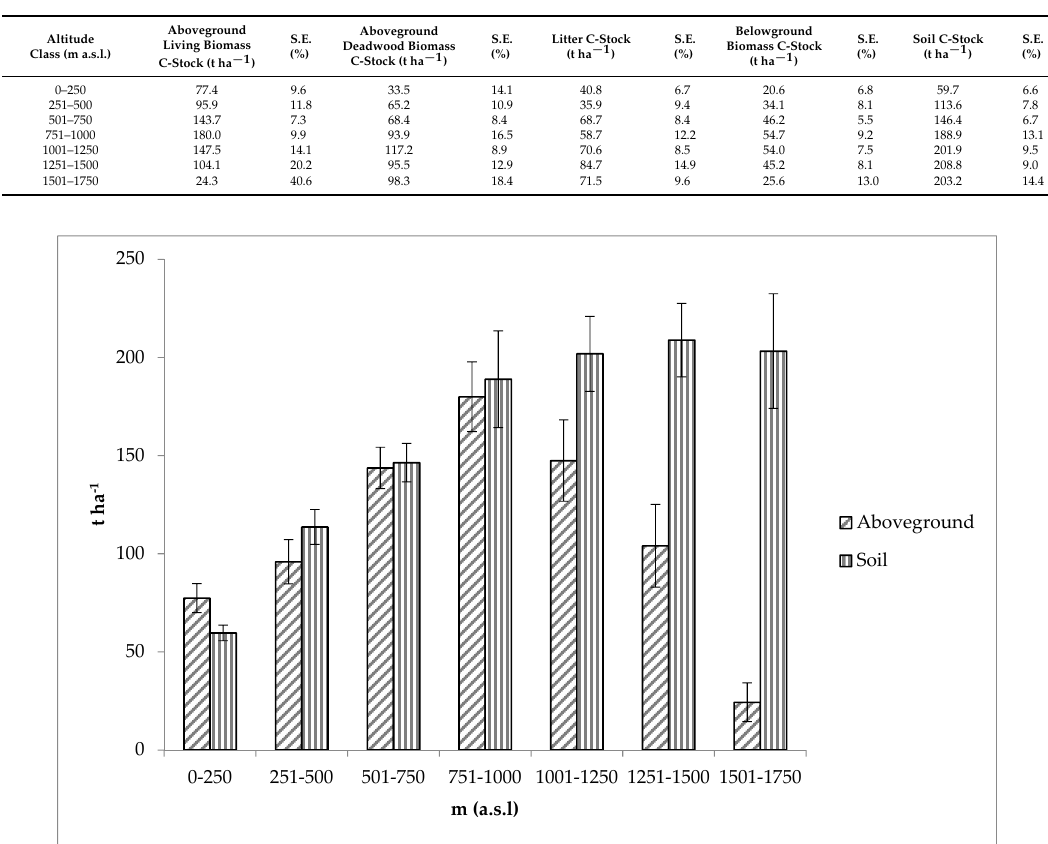
Figure 3. C-stock per hectare for aboveground living biomass (Aboveground) and soil (Soil) by altitude class (m a.s.l.) with one standard error.